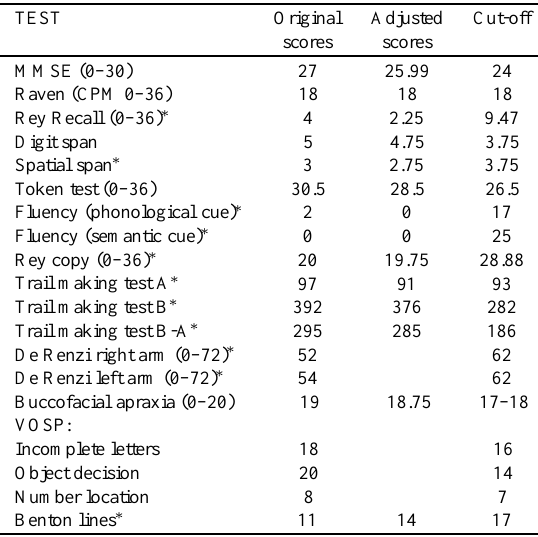
Table 1 General neuropsychology (July